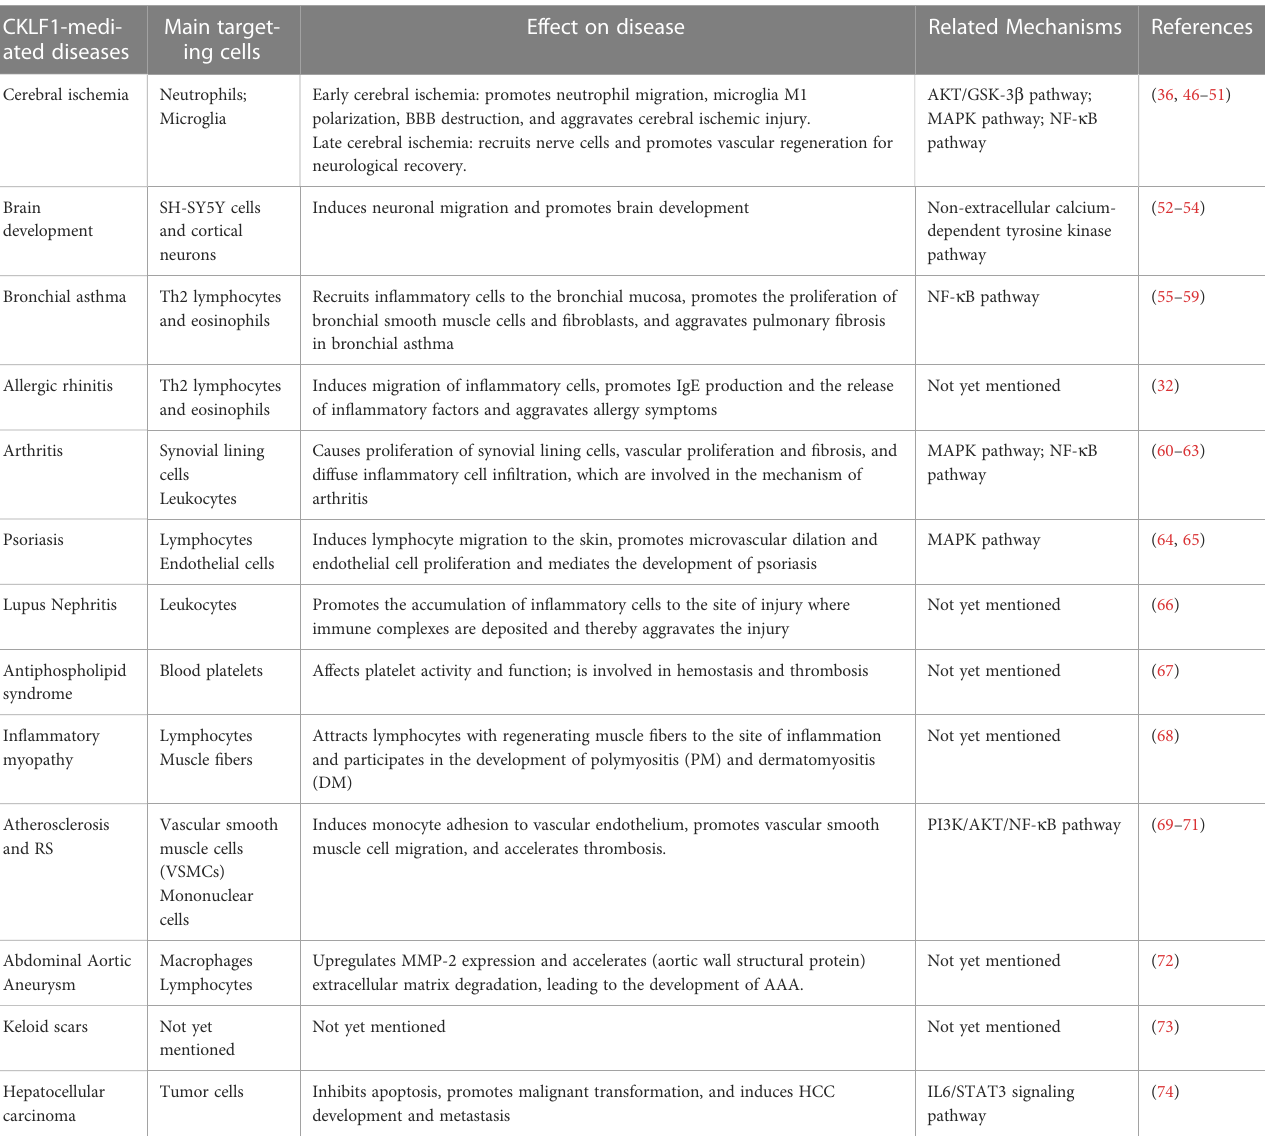
TABLE 1 The association of CKLF1 with